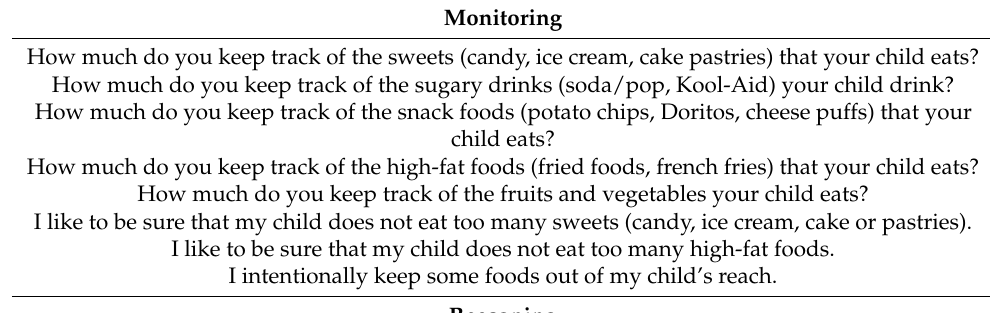
Table 2. Items of parent survey to identify parenting